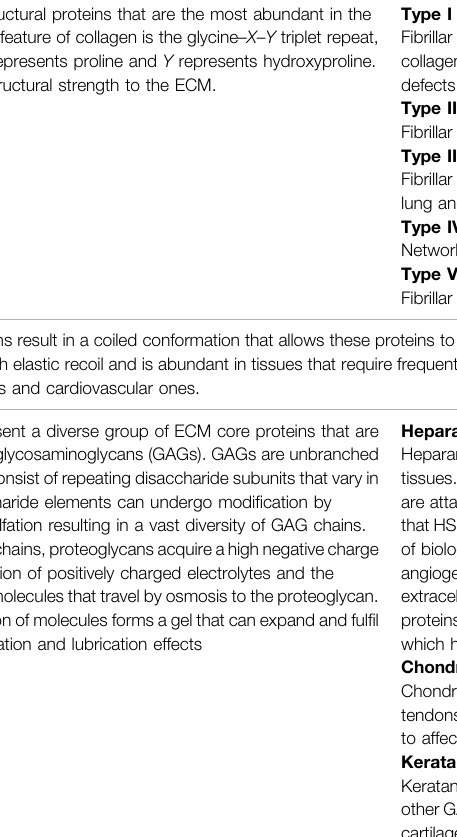
TABLE 1 | Description of the most common components that contribute to forming the ECM. ECM